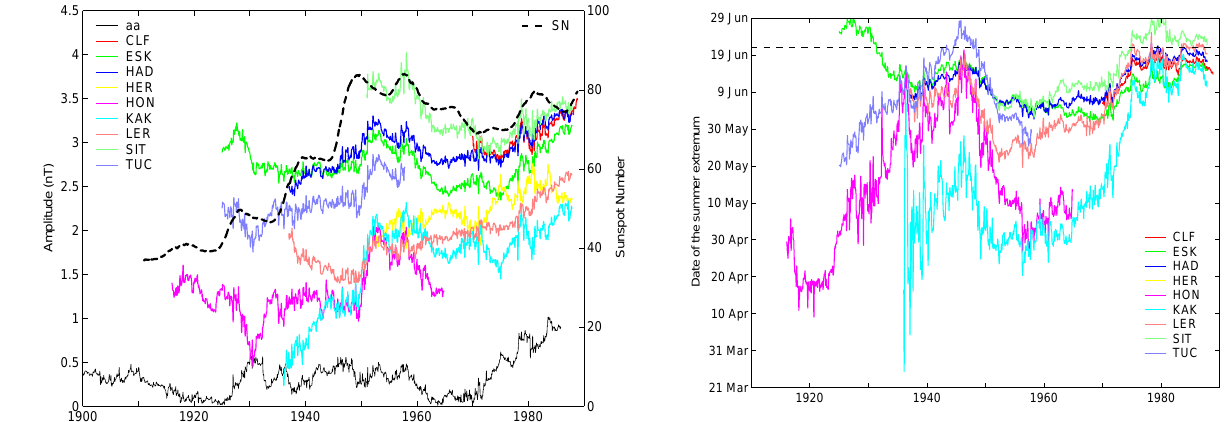
Fig. 9. Time variation of the phase of the annual variation of the X component in nine observatories, computed using a 22-year sliding window, centered. Phases are reckoned as the dates of the summer